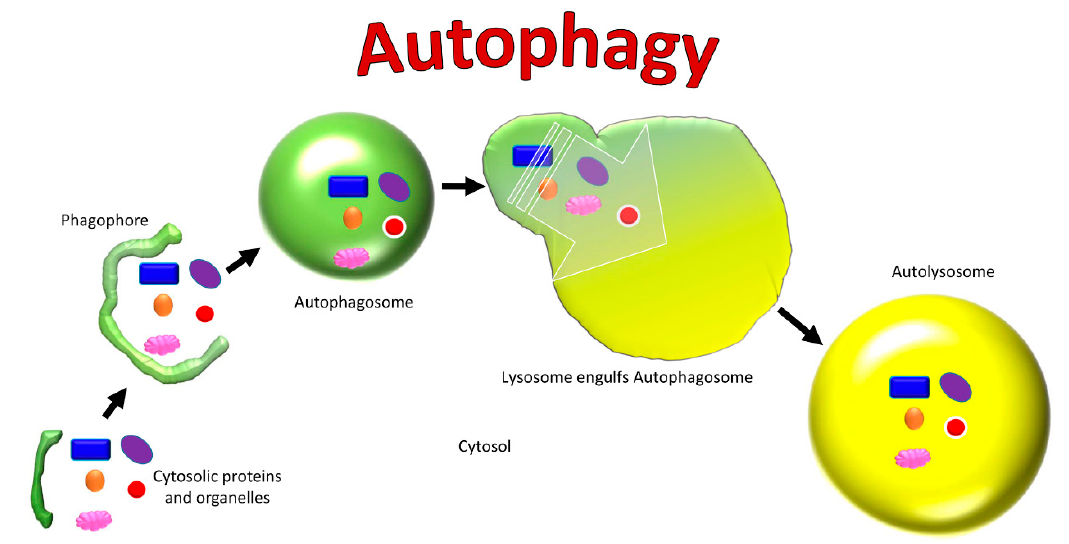
Figure 2. Cellular changes in autophagy.